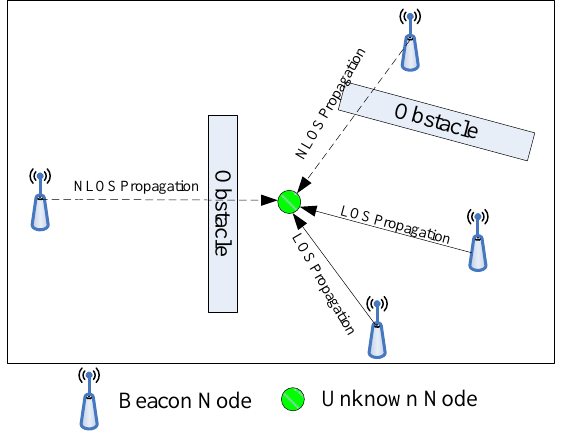
Figure 1. The localization result of the proposed algorithm.